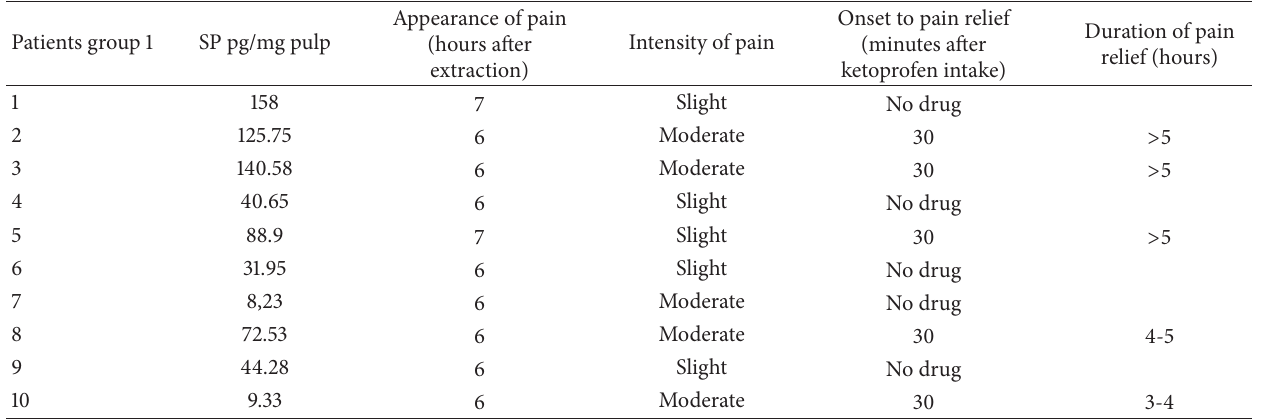
Table 1: Substance P and pain evaluation after tooth extraction of upper third molars with experimentally induced pulpal lesion, in patients with ketoprofen administration 30 minutes before the